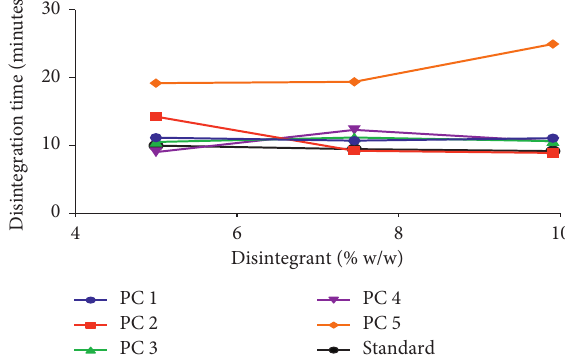
Figure 5: Effect of pectin concentrations as disintegrants on disintegration time.